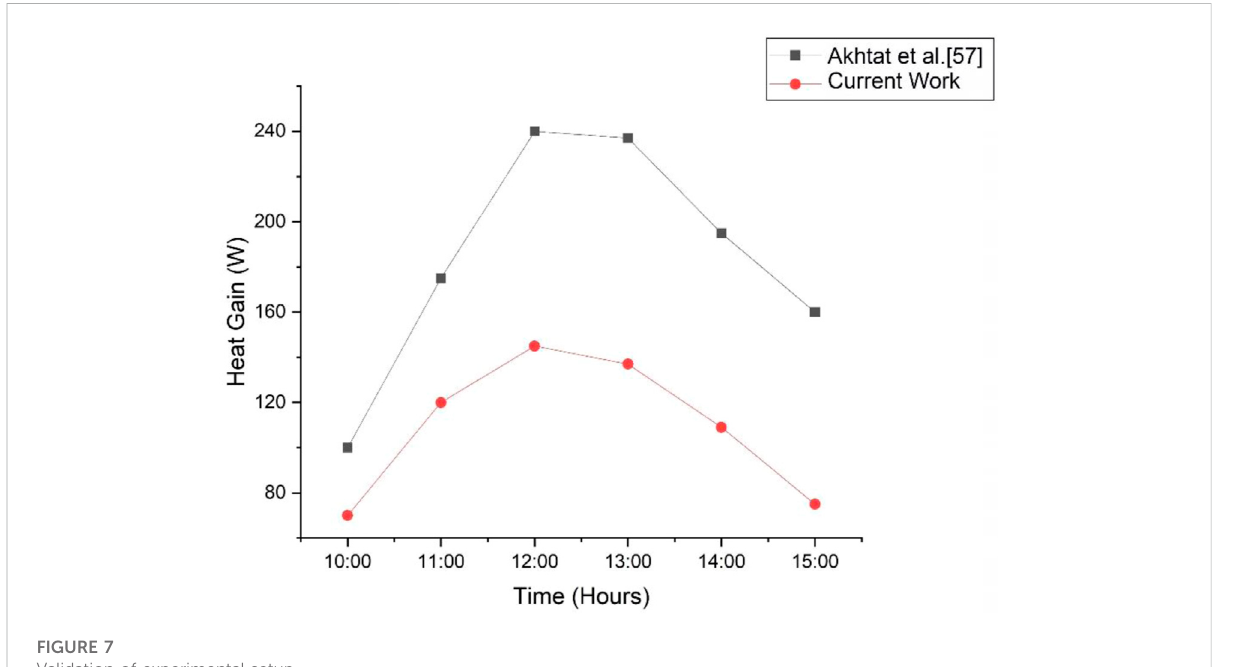
FIGURE 7 Validation of experimental setup.